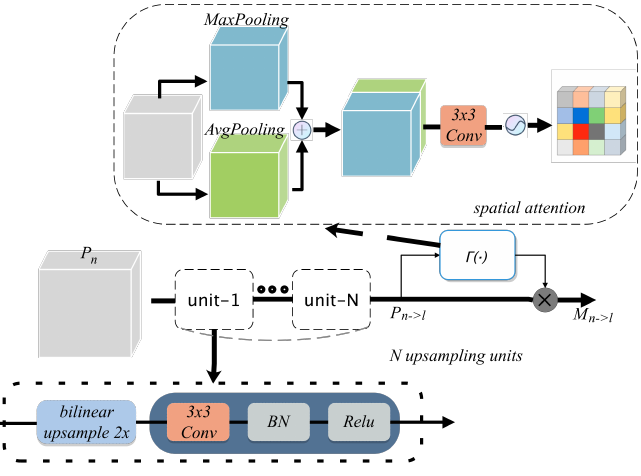
Figure 5. Description of the AFE.